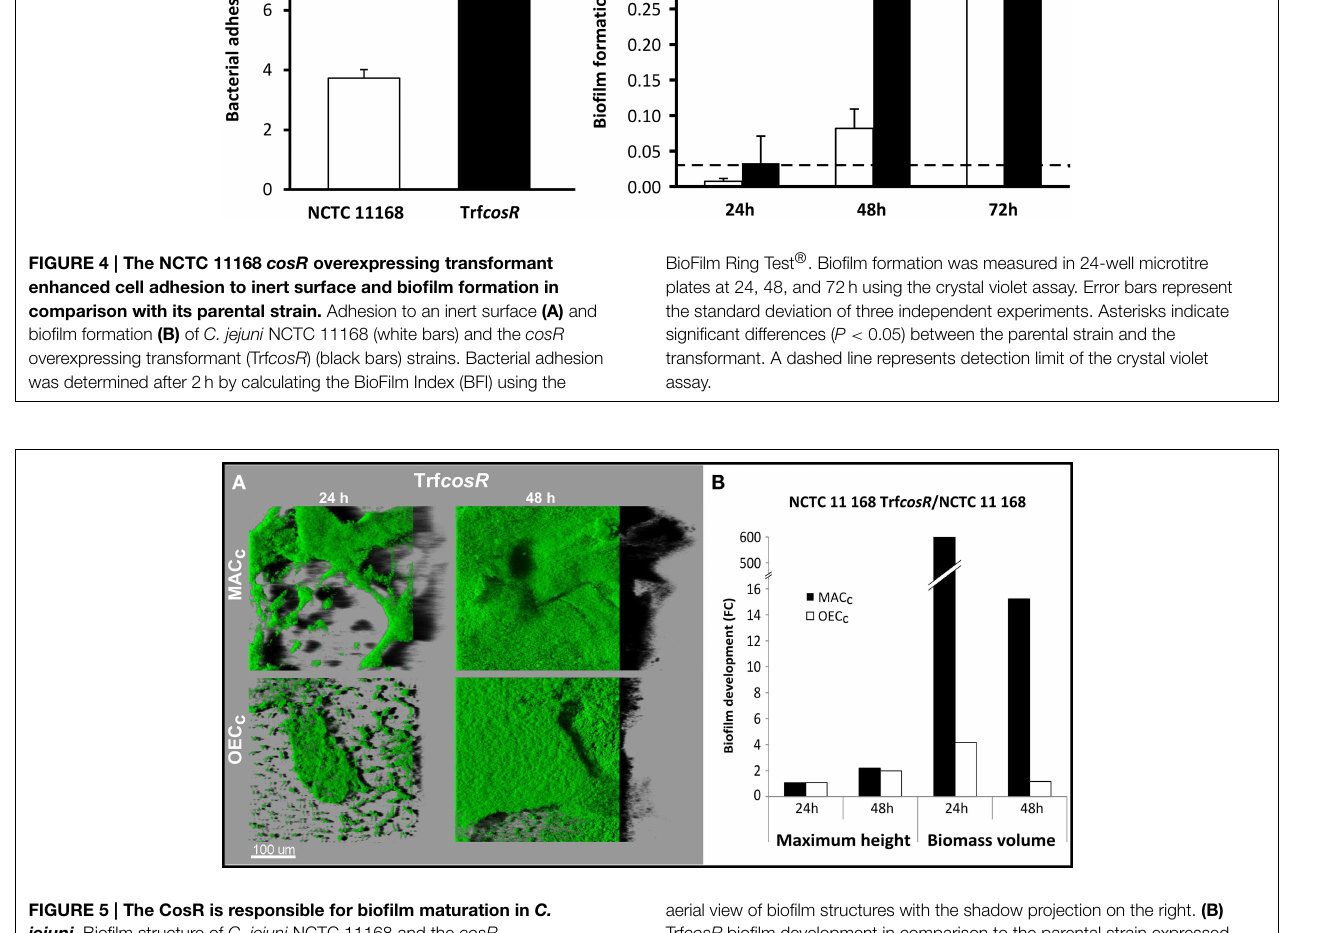
aerial view of biofilm structures with the shadow projection on the right. (B) Trf cosR biofilm development in comparison to the parental strain expressed as a fold changes of maximum height and biomass volume. Statistical data are presented in Supplementary Tables 4,